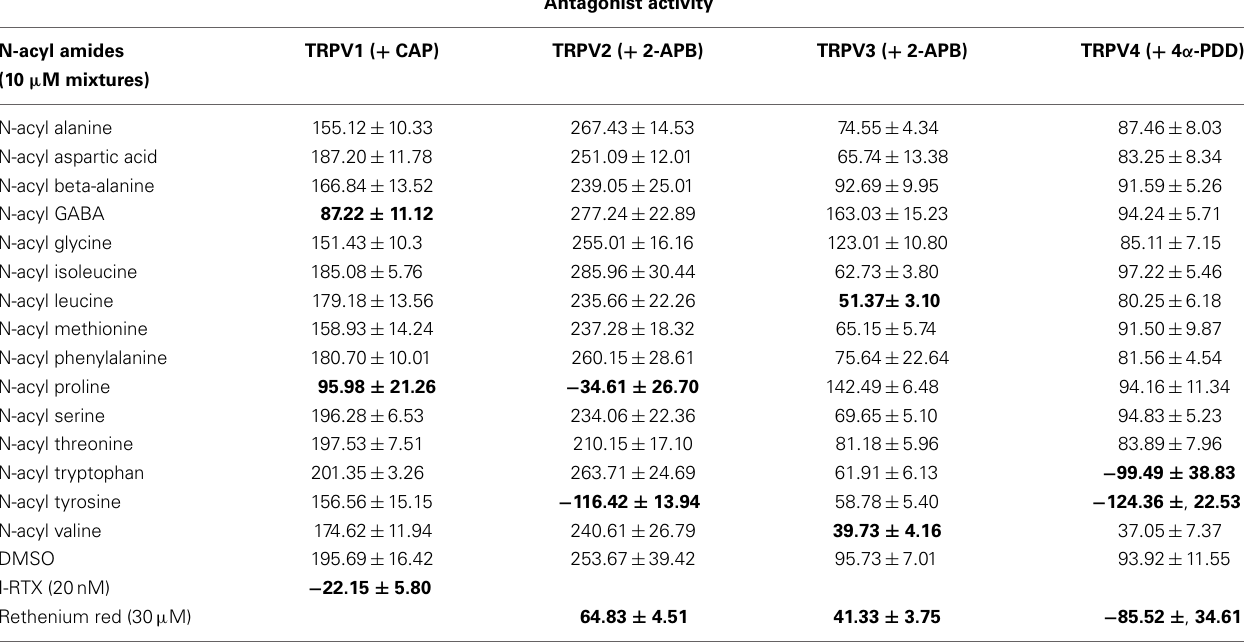
Table 2 | Antagonist activity of N -acyl amides at